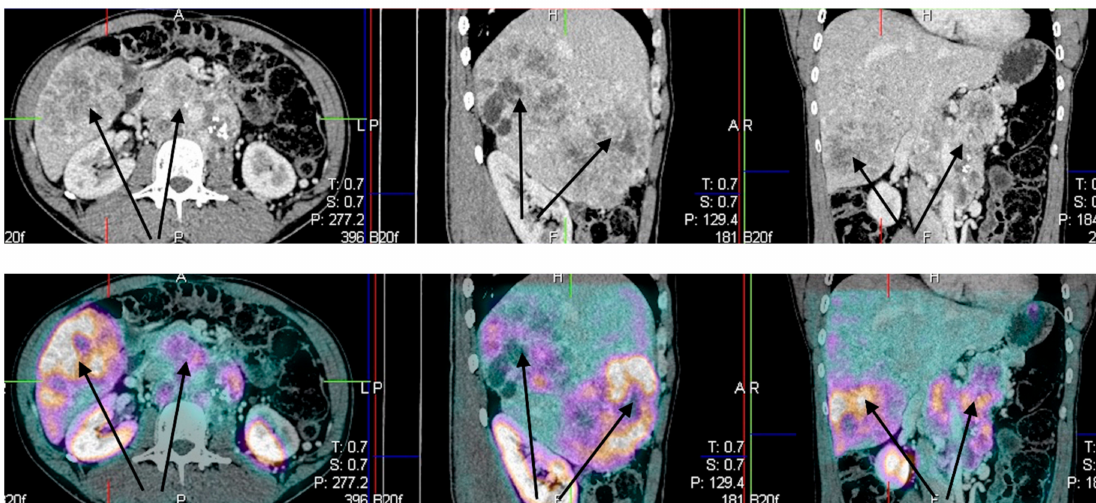
Figure 6. Male, 35 year-old patient with PGL4, standard CT upper panel ( A ) arrows indicated liver and lymph node involvement, and image fusion–lower panel ( B ) SPECT / CT somatostatin receptor scintigraphy (SRS) using 99 mTc HYNICTOC (Tektrotyd ® , Polatom,